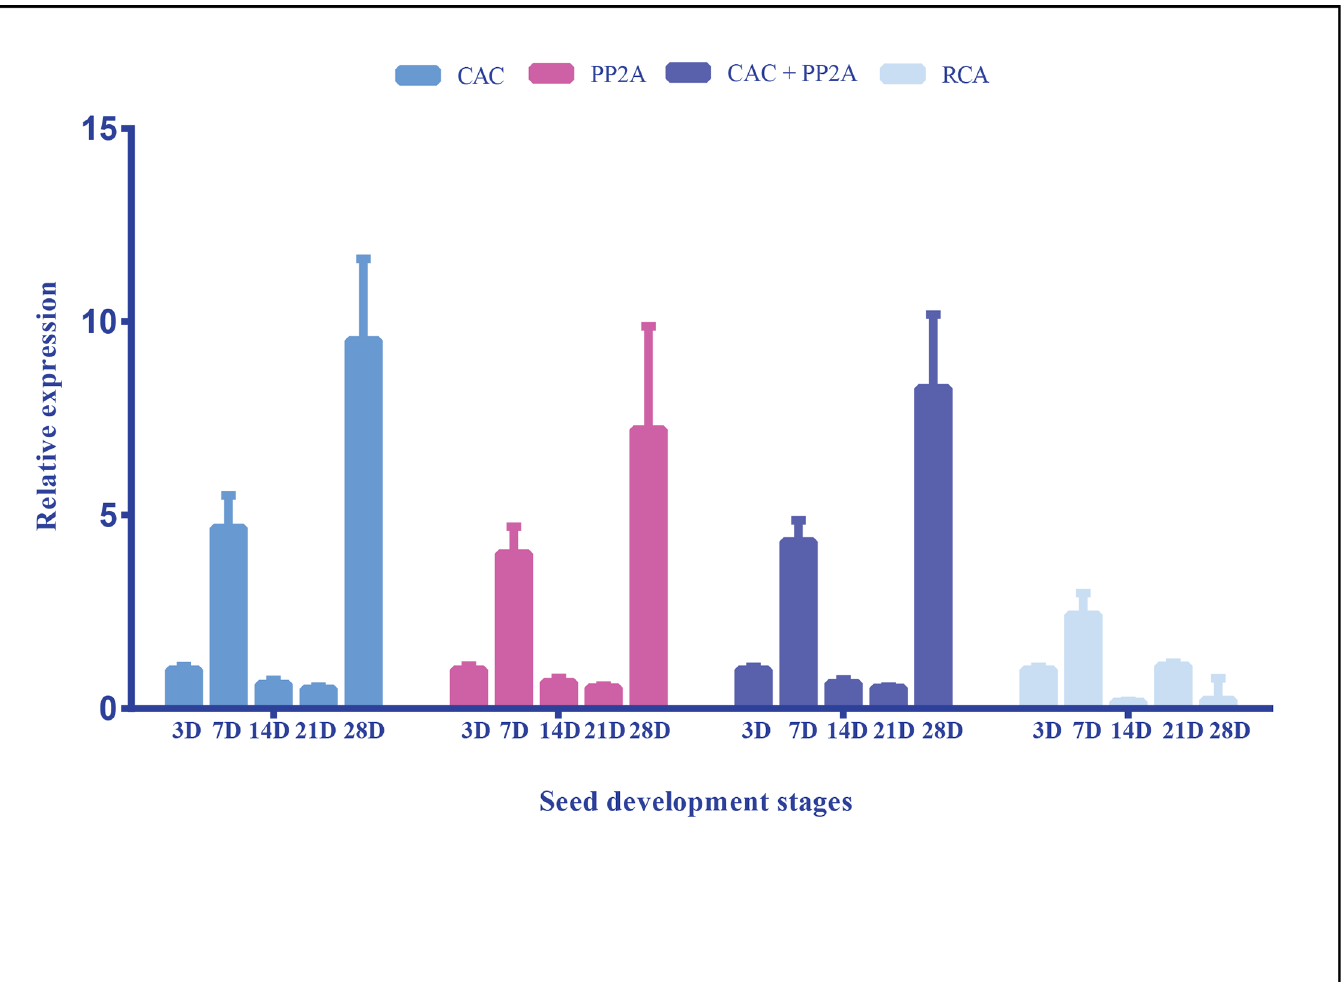
Fig 6. Validation of the reference genes in reproductive stage group. The relative expressionlevels of DGAT1 was normalizedby using the two most stable genes, PP2A and CAC in combination and individually,and also with the least stable gene, RCA. D representsDAF–Days after flowering. Values shown are relativeexpressionlevels ± SD (n =